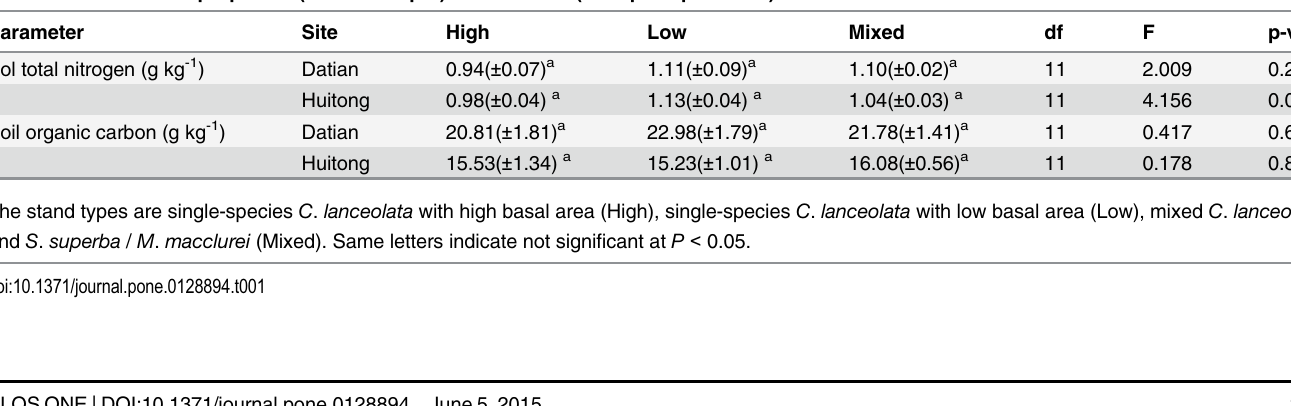
Table 1. Soil chemical properties (0 – 40 cm depth) of the stands (n = 5 plots per stand). Parameter